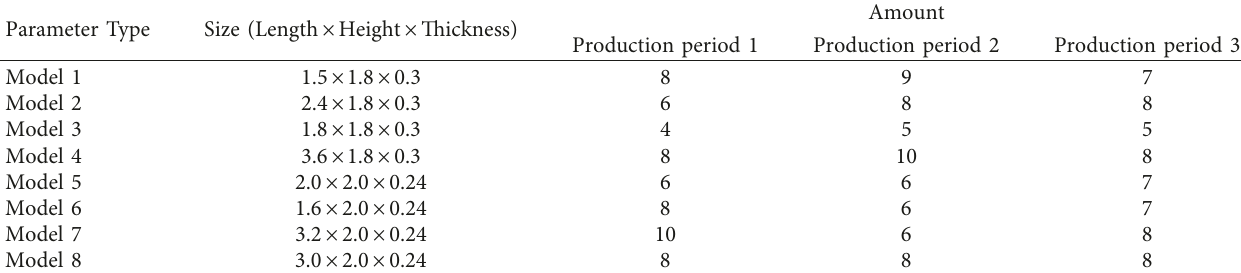
Table 2: The size and amounts of different types of prefabricated walls.